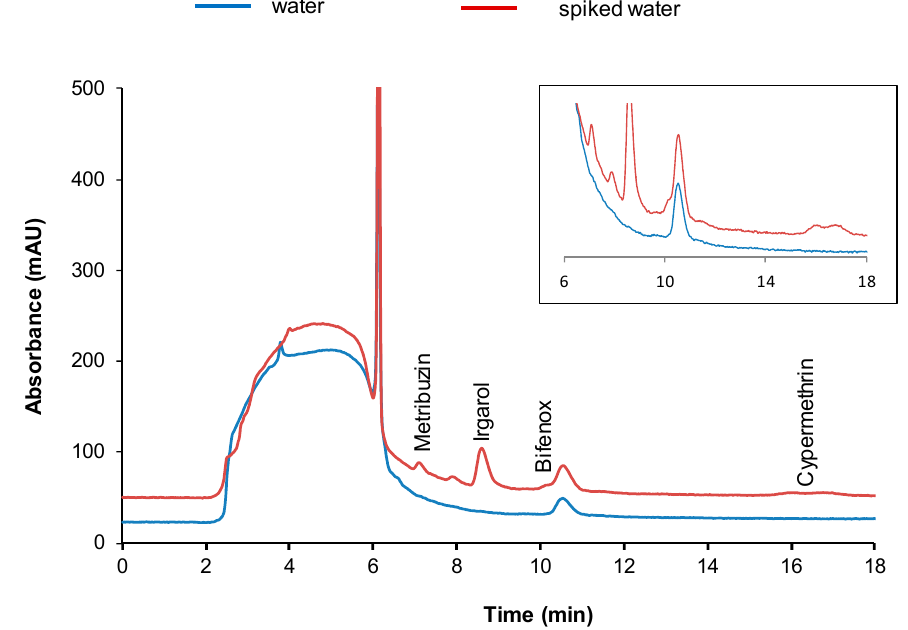
Figure 3. Chromatograms obtained under the proposed conditions for a real water sample and the sample spiked with metribuzin, irgarol, bifenox (25 μ g/L), and cypermethrin (125 μ g/L).